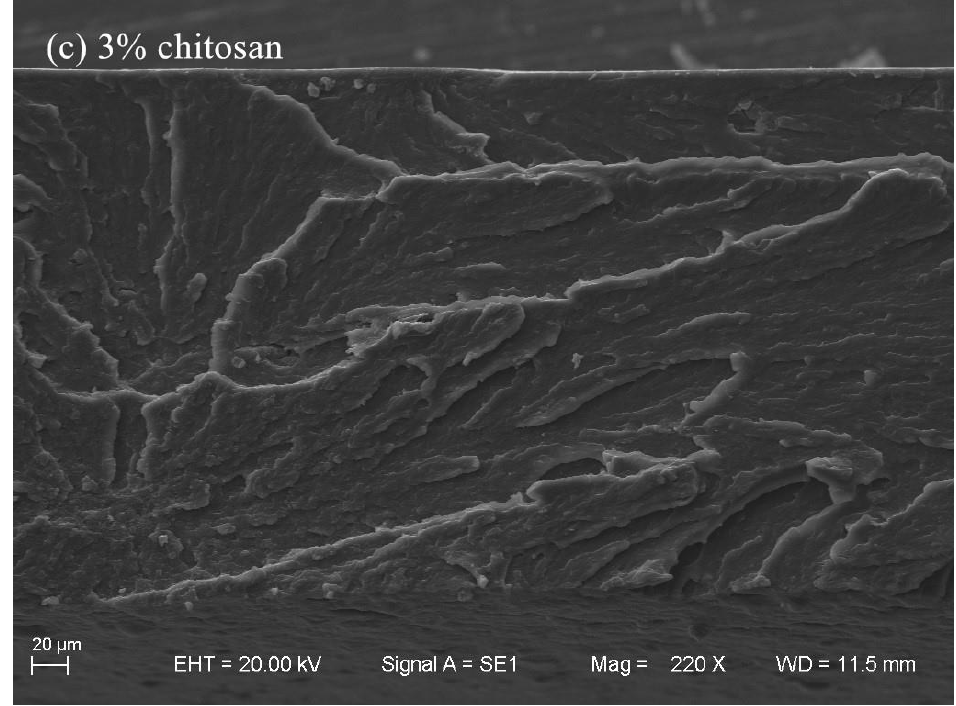
Figure 6. SEM micrographs of the tensile fractured surfaces’ panorama of chitosan films. Chitosan concentration is ( a ) 1%, ( b ) 2% and ( c ) 3%